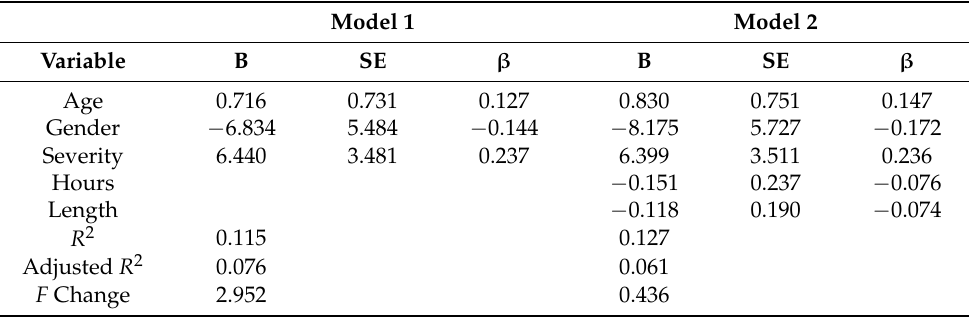
Table 5. Hierarchical Regression Analysis for Prediction of Autism Symptom